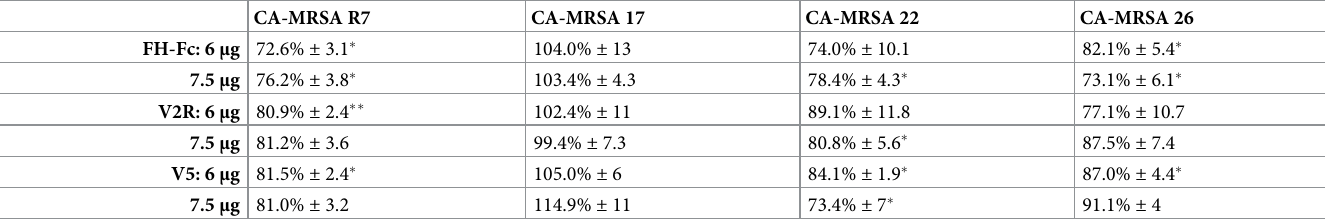
Table 3. CA-MRSA percent survival in 10% NHS with PMNs; fusion-protein treatment relative to no-treatment control.